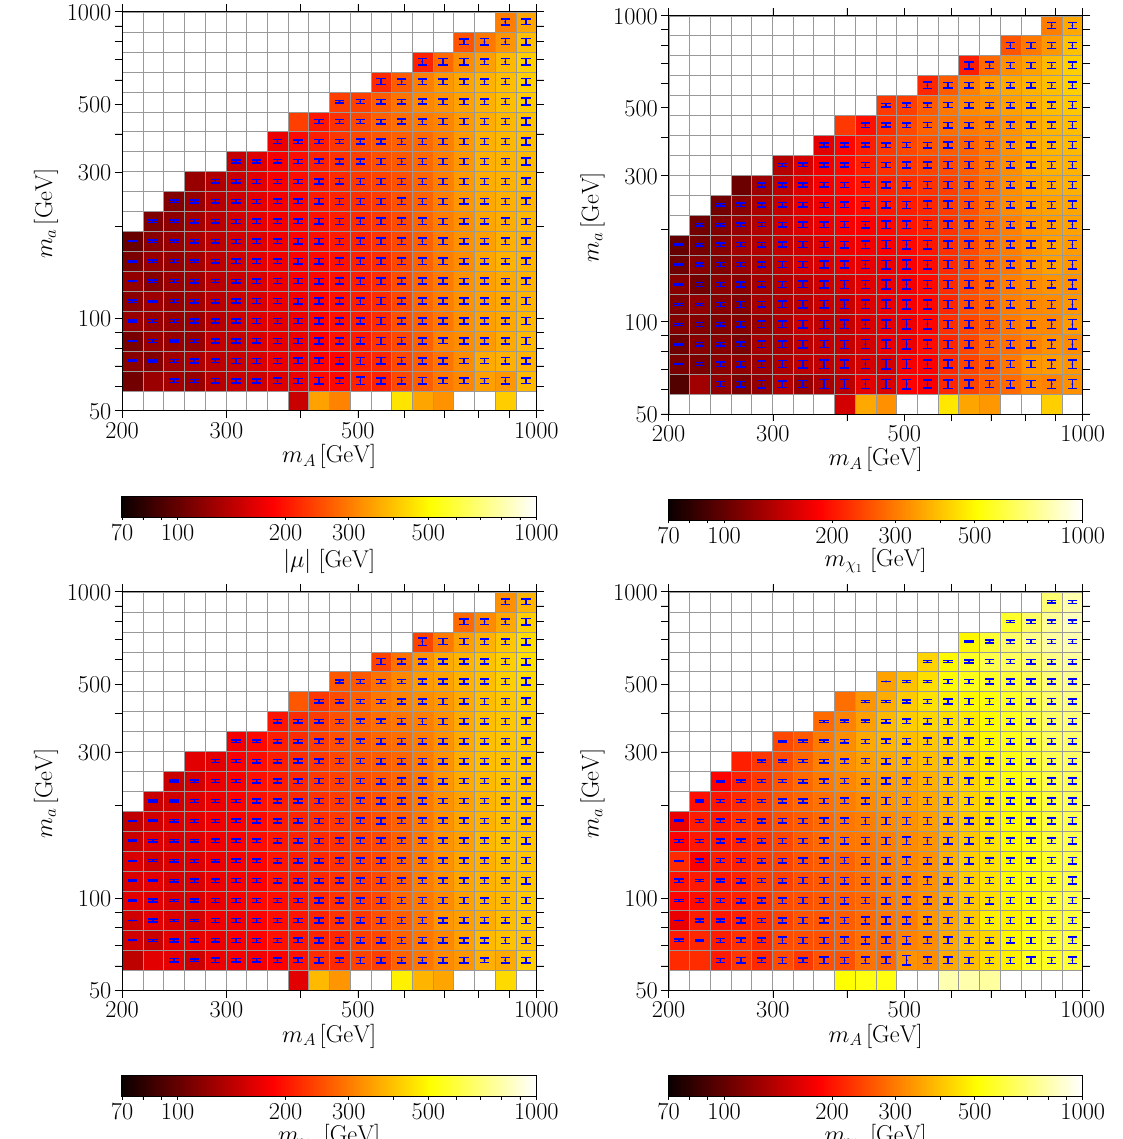
Figure 2 . Same as (cid:12)gure 1, but the top left panel shows the (cid:22) parameter and the remaining three panels the masses of the 3 lightest neutralinos. Note that due to the choices of parameters in our scan, i.e. decoupling the bino and the wino by choosing their mass parameters fj M 1 ; j M 2 jg (cid:29) j (cid:22) j , the 3 lightest neutralinos are dominantly composed of the Higgsinos and the singlino.